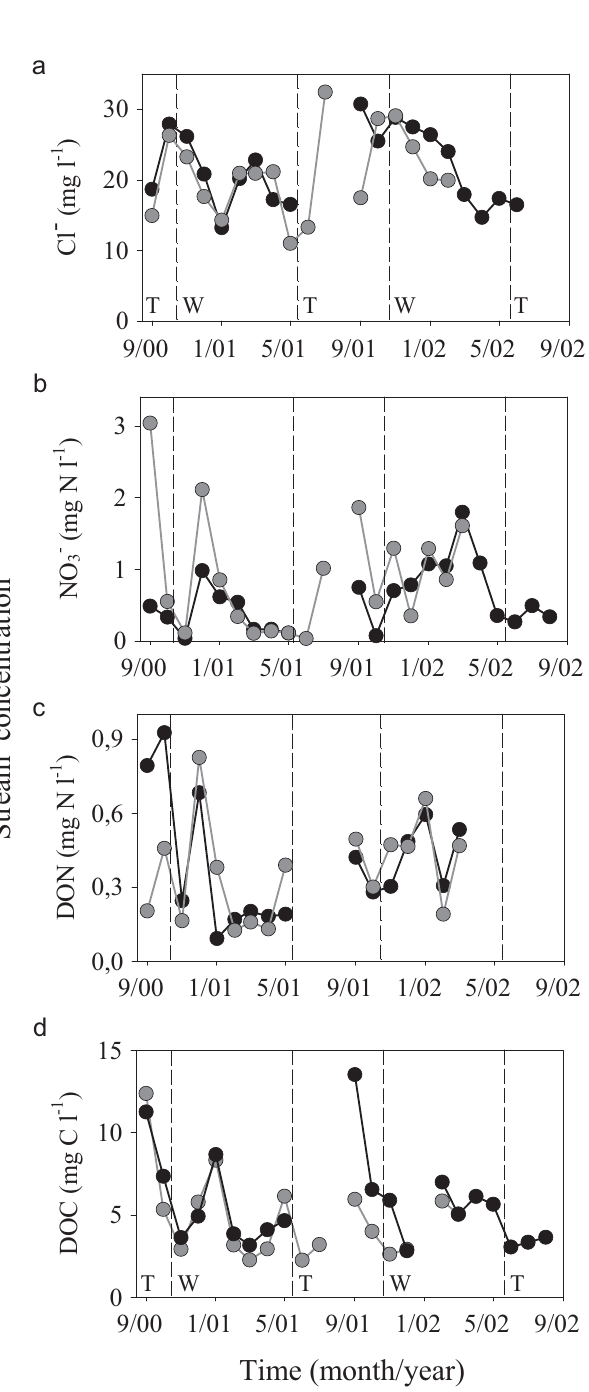
Fig. 3. Monthly volume-weighted solute concentration for (a) Cl − , (b) NO − , (c) DON, and (d) DOC at the hillslope (grey) and the 3 valley-bottom (black) streams during the study period. T: transition period; W: wet